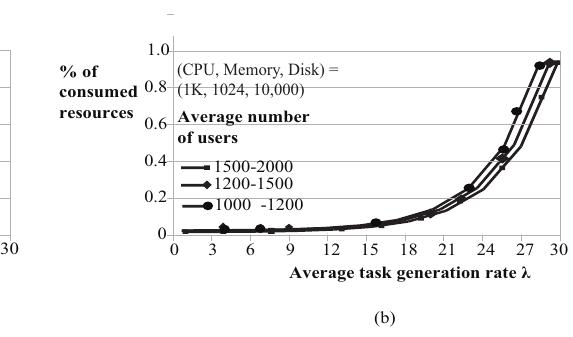
Figure 7. The DSQ